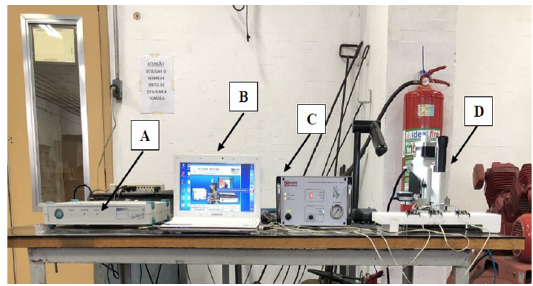
Figure 3. MTS3000 system for high-speed drilling. (A) Spider 8.30 Amplifier; (B) Control software (RSM) and post-processing (EVAL); (C) Electronic control unit; (D) Optical system and drilling system.